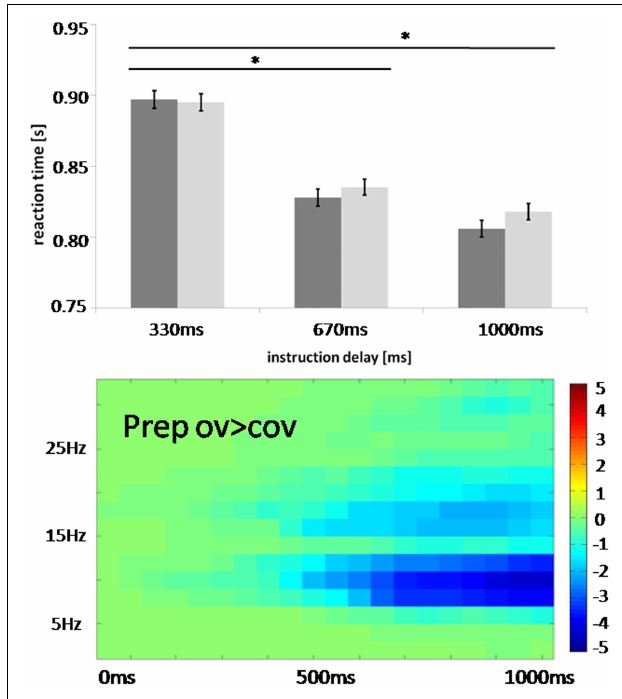
FIGURE 9 | Comparison of behavioral task set effects from 84 participants with the temporal evolution of oscillations in the actual study. Instruction delay between cue and target presentation varied between 330, 670, and 1000ms. Reaction time was measured as speech onset for neutral (dark gray) and happy intonation (light gray) after target presentation. Error bars indicate standard error, *significance at p < 0.05 corrected. Note that the set up of the speech production network coincides with occurrence of alpha and beta